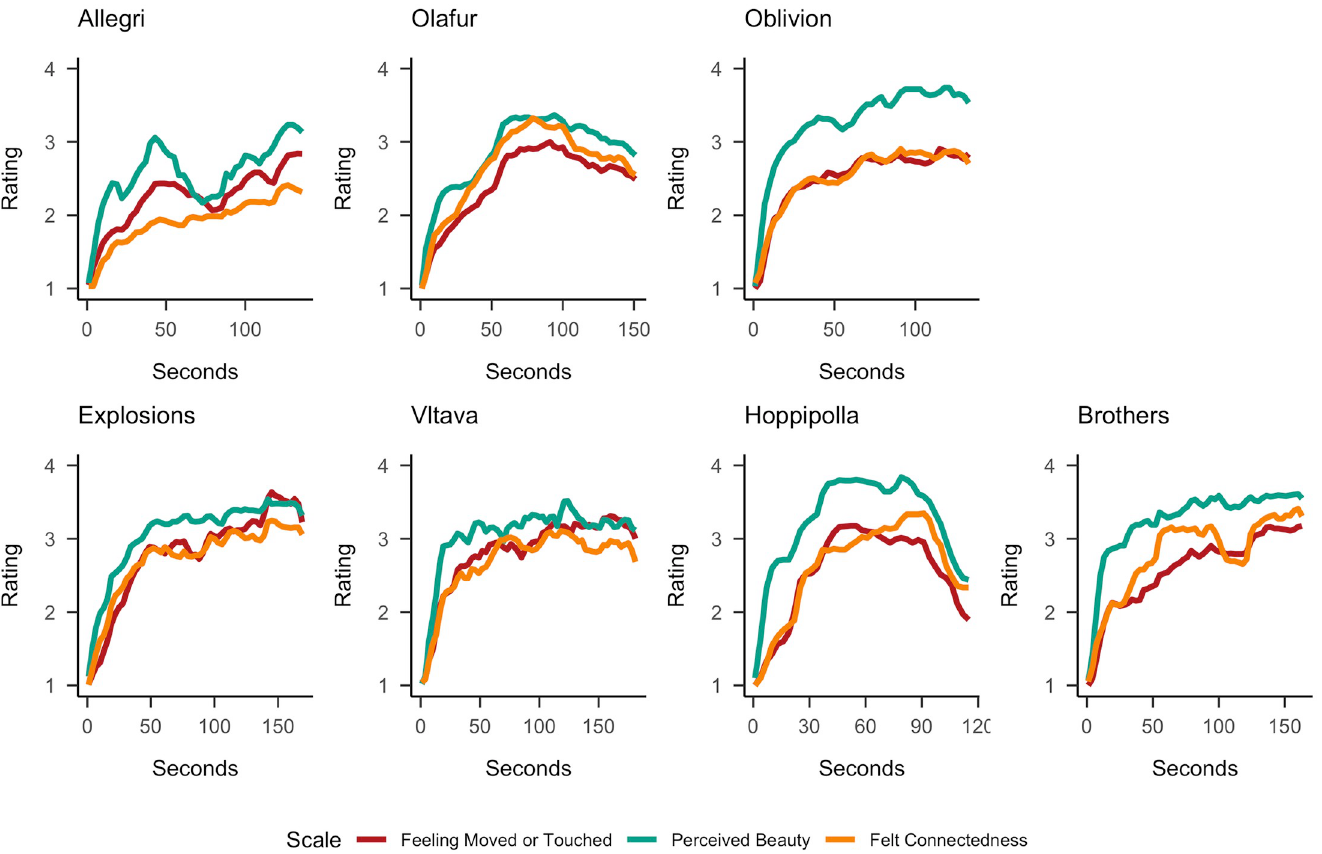
Fig 3. The averaged non-detrended continuous ratings of feeling moved or touched , perceived beauty , and feeling a sense of connection for the sadly (Upper Row) and joyfully moving (Lower Row) music excerpts. Ratings were provided on a 5-point scale (ranging from 1 (not at all) to 5 (extremely)) and aggregated in 3s time